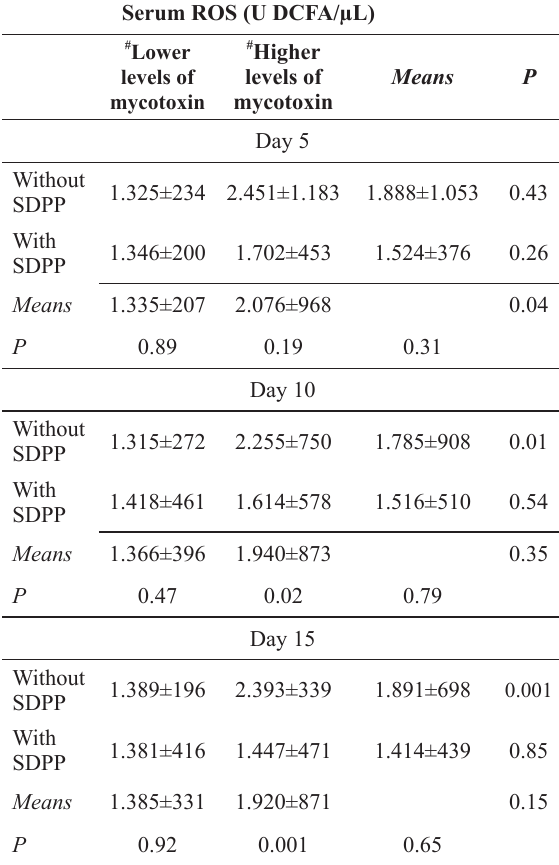
Levels of reactive oxygen species (ROS) in serum of piglets fed with mycotoxin diet and supplemented with spray-dried porcine plasma (SDPP). Note: At days 10 and 15 serum ROS levels interacted with SDPP and mycotoxin factors ( P <0.05), i.e., SDPP was able to neutralize the mycotoxin-induced increase of ROS